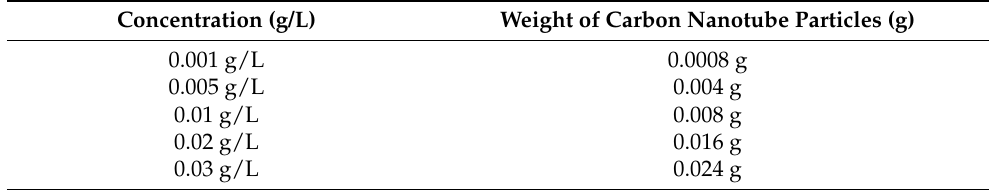
Table 2. Concentration of nanofluid used.